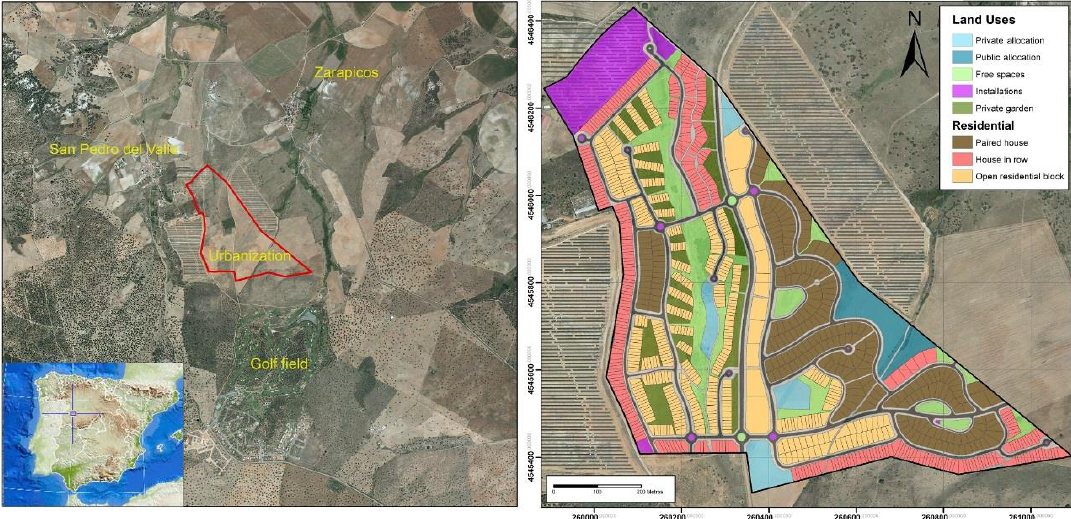
Figure 1. Study area ( left ) and distribution of the community services and residential uses ( right ).